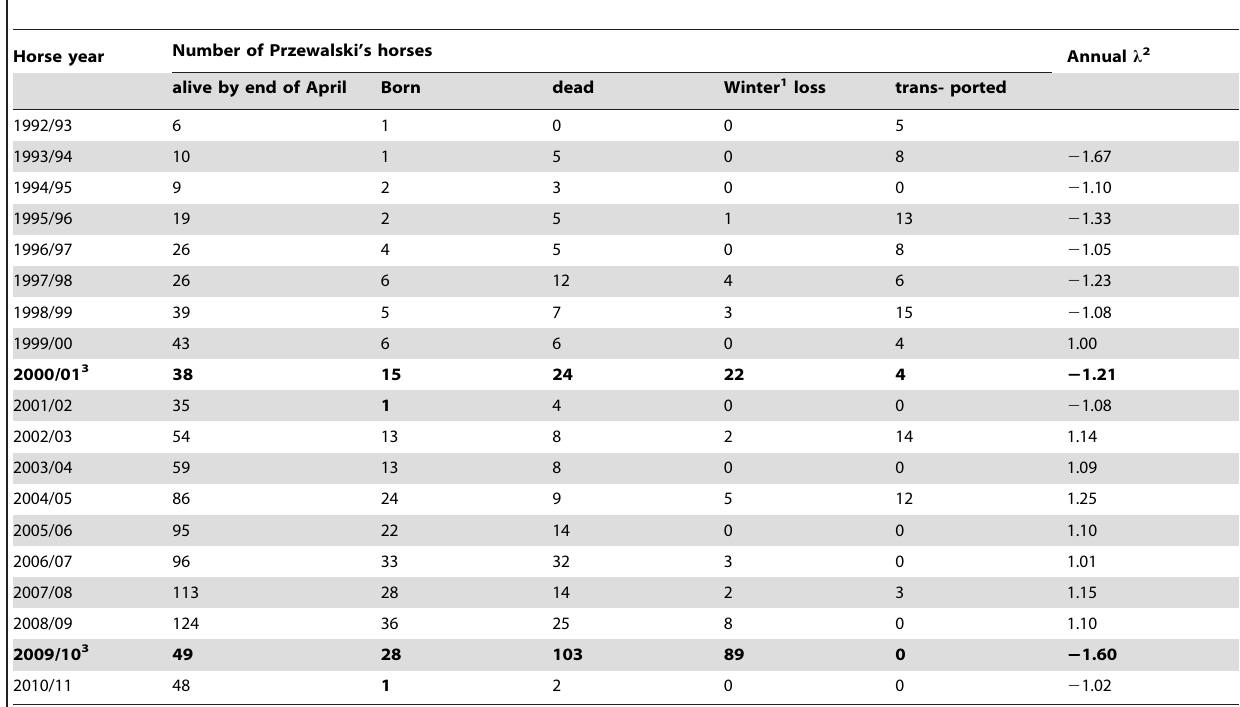
Table 2. Population development of the re-introduced Przewalski’s horse population in the Great Gobi B Strictly Protected Area